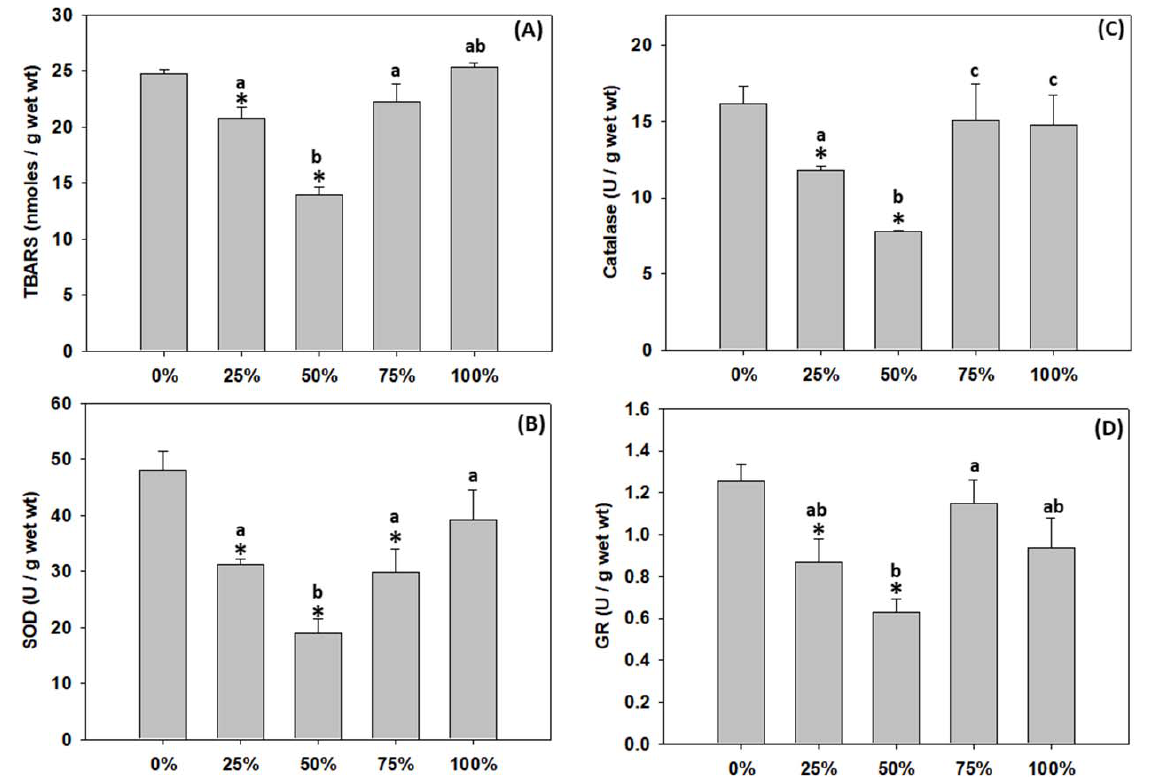
Figure 5. ( A ) TBARS levels, ( B ) SOD, ( C ) catalase and ( D ) GR enzymatic activity levels (mean ± SD) of Tenebrio molitor larvae reared on substrates containing different content levels of milled carob pods (0, 25, 50, 75 and 100%). Asterisk (*) indicates p < 0.05 compared to 0%, while lower case letters indicate p < 0.05 compared to different carob contents (%).